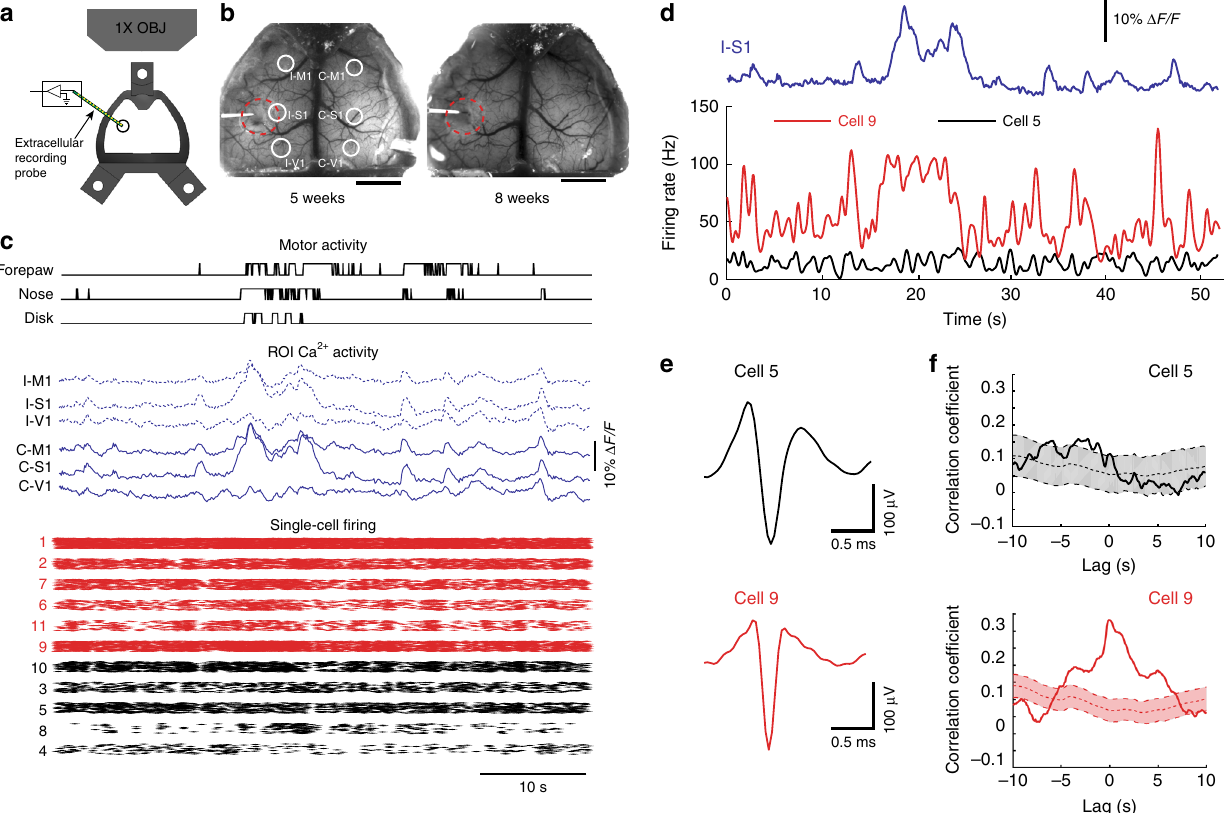
Fig. 5 Simultaneous extracellular recordings with wide- fi eld Ca 2 + imaging and behavioral tracking. a Schematic of implanted See-Shells with perforation over the primary somatosensory cortex allowing insertion of a multi-channel silicon-based neural probe. b Photographs of a Thy1-GCaMP6f mouse implanted with a perforated See-Shell taken during two experimental sessions. Red dashed lines indicate the outline of perforation. White circles indicate regions of interest (ROIs) analyzed for extracting Ca 2 + traces. I-M1 ipsilateral primary motor cortex, I-S1 ipsilateral primary somatosensory cortex, I-V1 ipsilateral primary visual cortex, C-M1 contralateral primary motor cortex, C-S1 contralateral primary somatosensory cortex, C-V1 contralateral primary visual cortex. Scale bars indicate 2 mm. c Simultaneously recorded disk, nose, and forelimb movements, aligned with Ca 2 + activity traces in the ROIs indicated in b , and single unit spike raster plots recorded from the multi-channel silicon-based neural probe. Red raster plots indicate neurons with spike fi ring rates correlated with Ca 2 + activity in I-S1. Individual points from each cell were slightly shifted in a randomized fashion in the y axis for ease of visualization. d Spike fi ring rates of two representative cells, with one that was correlated with Ca 2 + activity in I-S1 (cell 9) and one that did not show correlation (cell 5). e Average action potential waveforms of the two cells shown in d . f Cross-correlation of fi ring rates of representative cells in d and Ca 2 + activity in I-S1 with 95% con fi dence interval of cross-correlations with 1000 bootstrapped shuf fl ed trials of the fi ring rate to determine signi fi cance NATURE COMMUNICATIONS| (2019) 10:1500